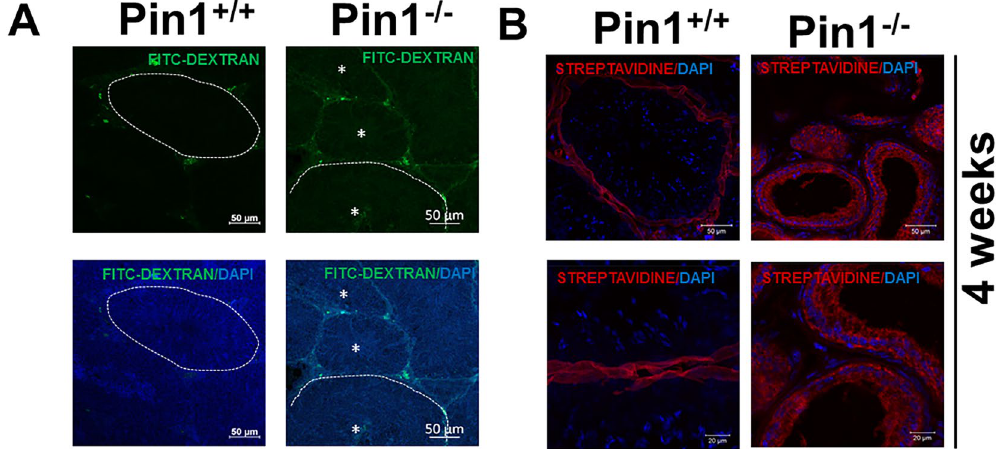
Figure 4. Pin1 − / − testes show a BTB defect. ( A ) Testes from mice injected with Dextran-FITC were analyzed for a BTB defect. Mice injected with Dextran-FITC through the jugular vein were sacrificed 2 hr later. Testes were fixed immediately and later paraffin embedded. Sections were cut and analyzed using FITC staining. The whole process was carried out with light protection (scale bar = 50 µ M). ( B ) A biotin tracer was injected in the interstitium of the testicular tissue, and samples were collected 30 min post sacrifice to further confirm the BTB defect. CY3-conjugated streptavidin was used to detect the presence of biotin in the adluminal compartment after frozen sectioning (upper panel scale bar = 50 µ M and lower panel scale bar = 20 µ